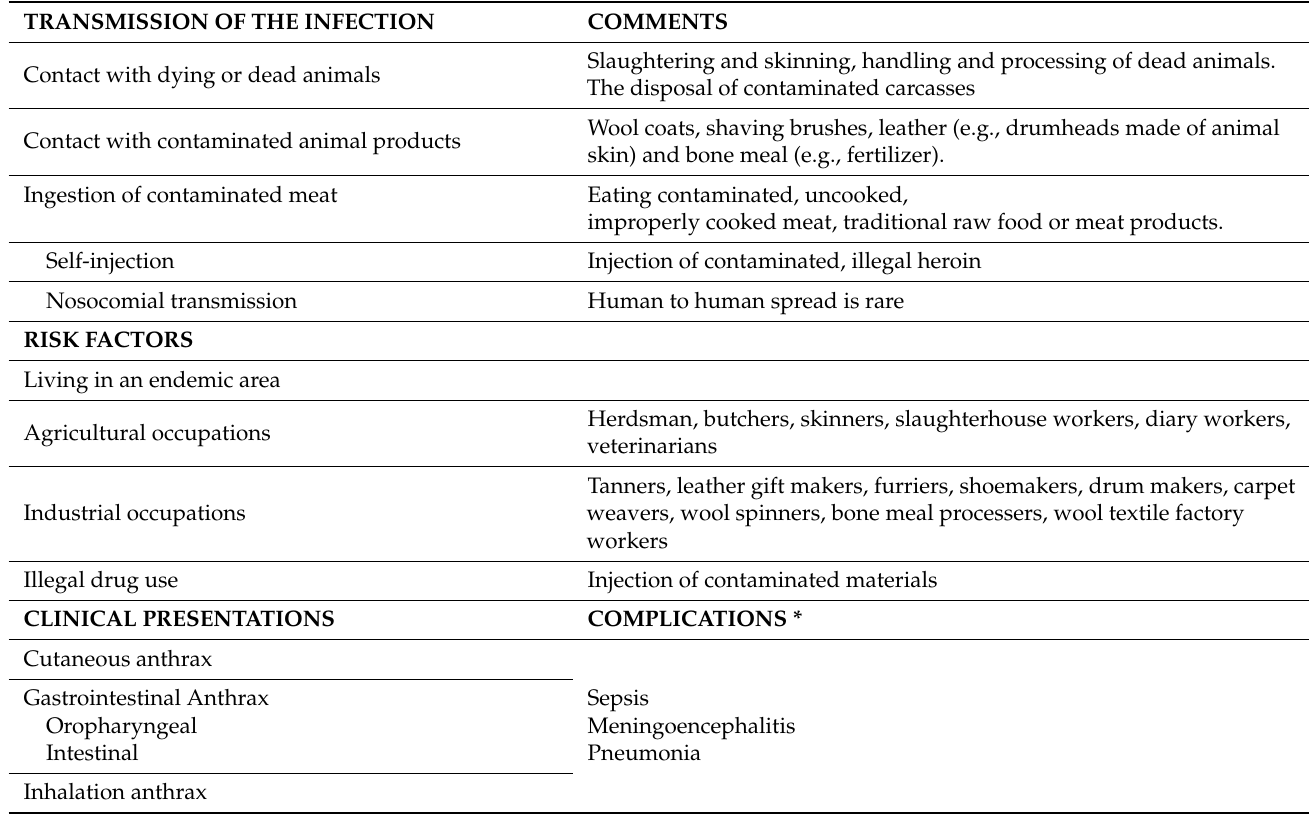
Table 1. Human anthrax: Common routes of transmission, risk factors and clinical